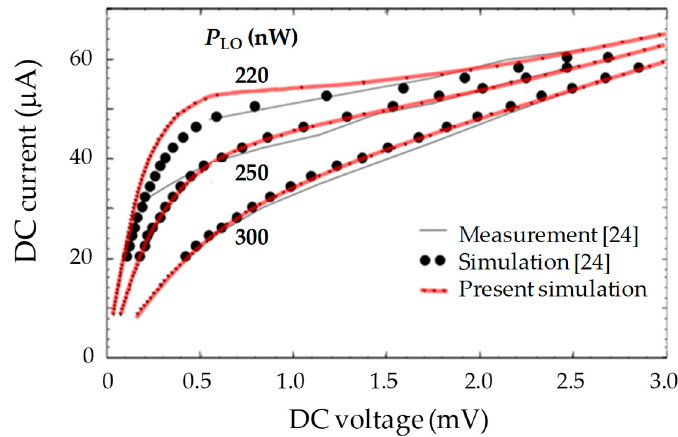
Figure 6. For the NbN HEB reported in Reference [24], the comparison between I - V plots measured on the fabricated device and simulation according to the model developed in Reference [24] and our present model.